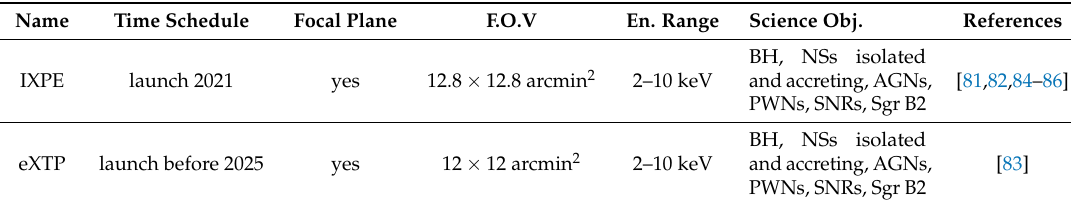
Table 3. Photoelectric X-ray polarimetric missions planned.